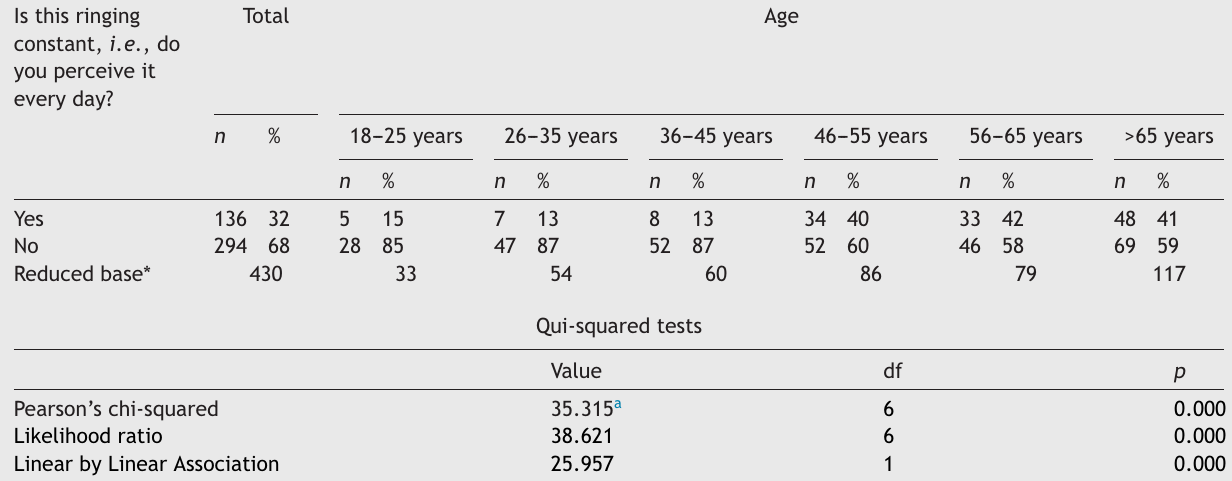
Prevalence of constant/intermittent tinnitus, according to the different age groups in the population of the city of São